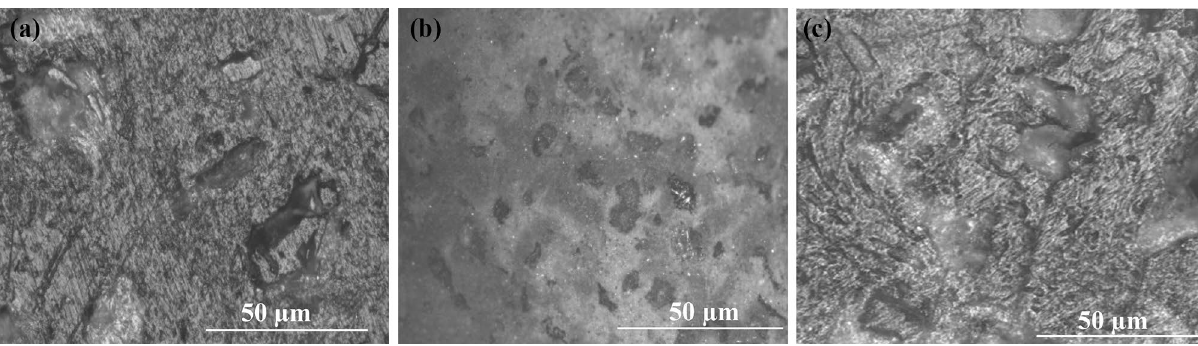
Figure 8. Surface image of specimens ( a ) 50% LDPE, ( b ) 50% HDPE, ( c ) 50% LDPE and 20%